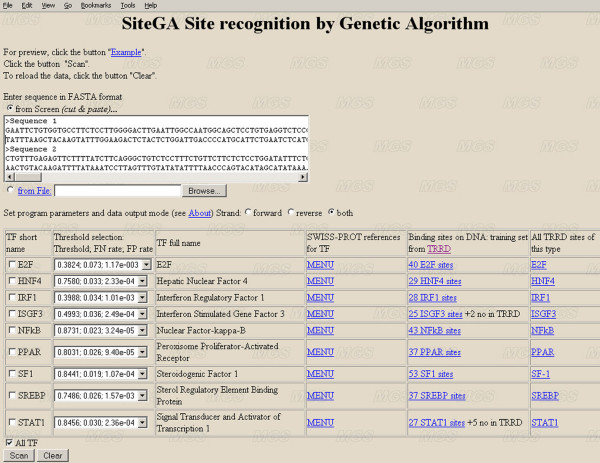
Web interface of the SiteGA tool.